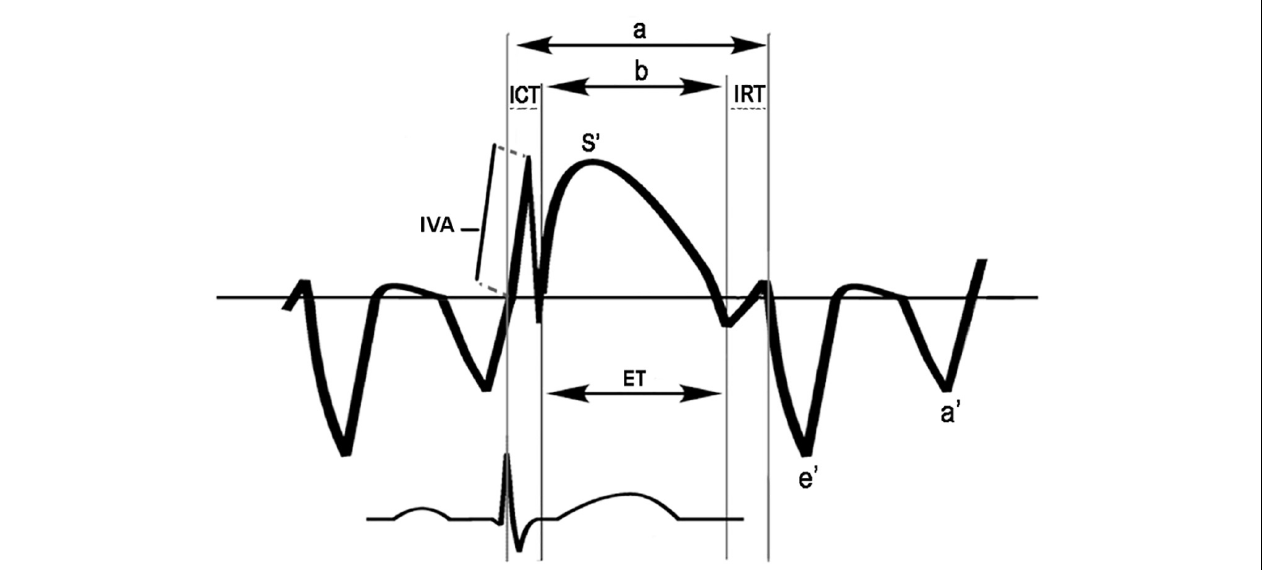
FIGURE 2 | Scheme for measurement of time intervals used to calculate the tissue Doppler-derived myocardial performance index (TDI-MPI) and IVA: The MPI index was calculated as (a-b)/b; a , time from cessation of the a’ wave to the onset of the e’ wave; b , the duration of the s’ wave; ET, ejection time; ICT, tissue Doppler-derived isovolumic contraction time; IRT, tissue Doppler-derived isovolumic relaxation time; IVA, myocardial acceleration during isovolumic contraction. The IVA was defined as the first positive deflection in the tissue Doppler signal at the end of the a’ wave. A line was drawn from the IVA onset to its peak, and a slope was measured.